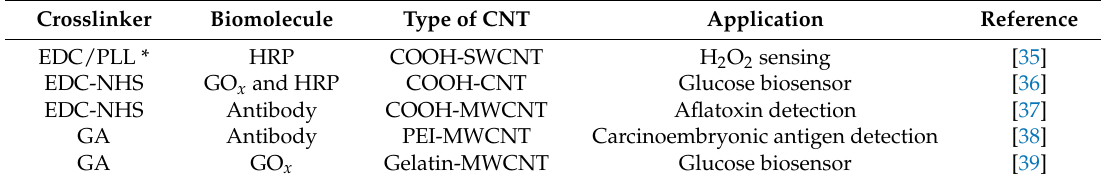
Table 1. List of applications that use covalent functionalization for biomolecule immobilization on carbon nanotubes.